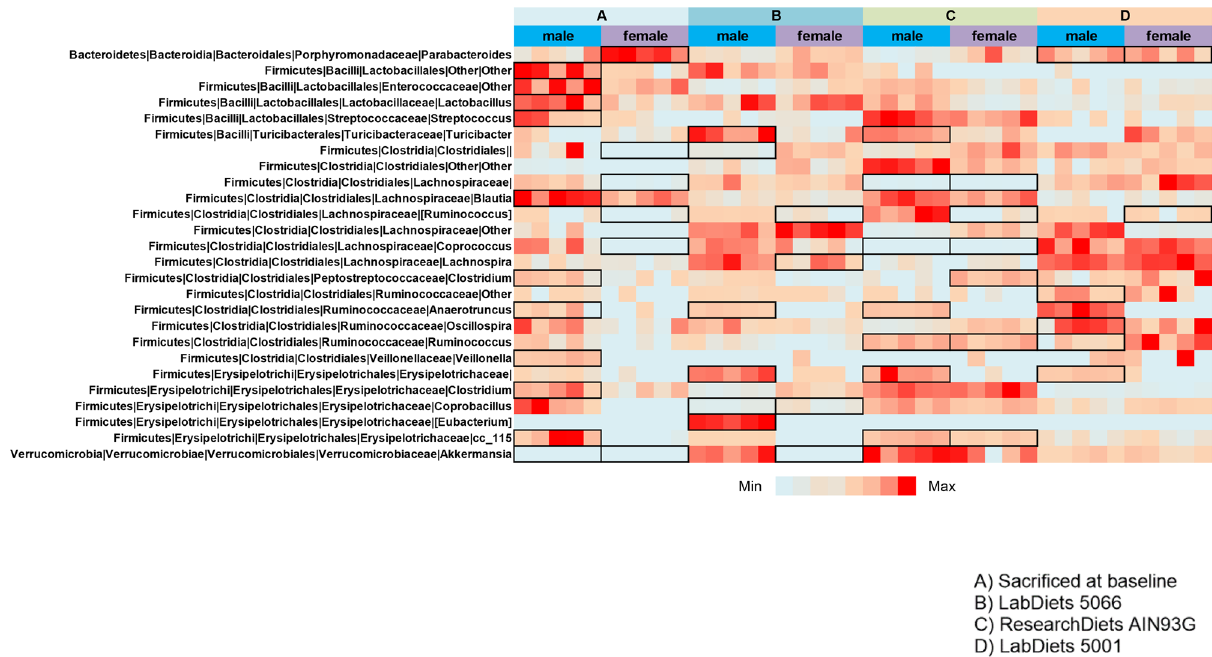
Figure 2. Different rodent diets significantly impact gut microbiota composition in a sex-dependent way. The data was analyzed with MaAslin to detect multivariable associations between bacterial genera and diets in each sex. Each bacterial genus significantly associated with diet and sex is highlighted by a black box.